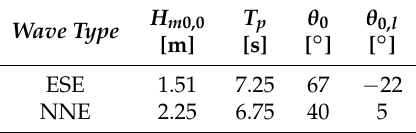
Table 1. Wave characteristics used at the offshore boundary of the numerical domain for the baseline simulations.